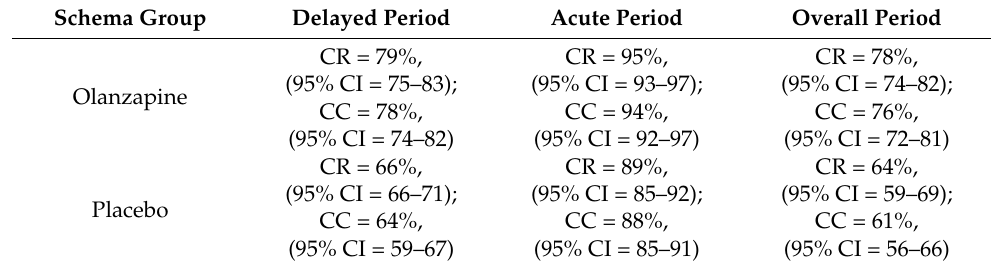
Table 2. The optimal dosing time for olanzapine. Schema